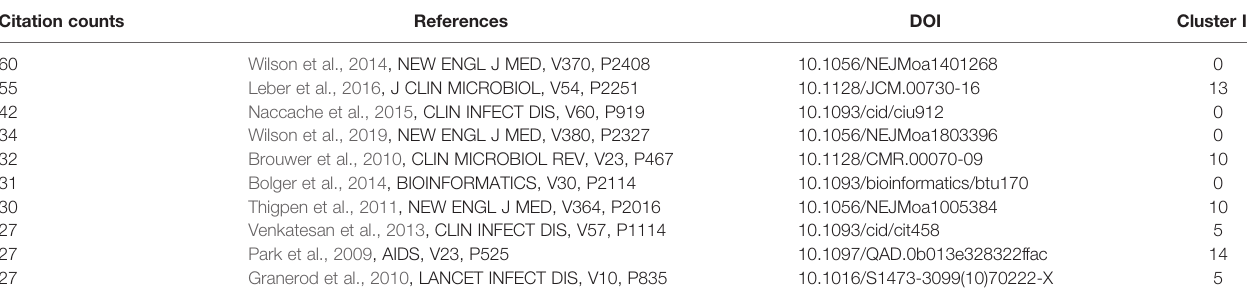
TABLE 6 | Top 10 highest cited publications on pathogen detection for CNS infections.